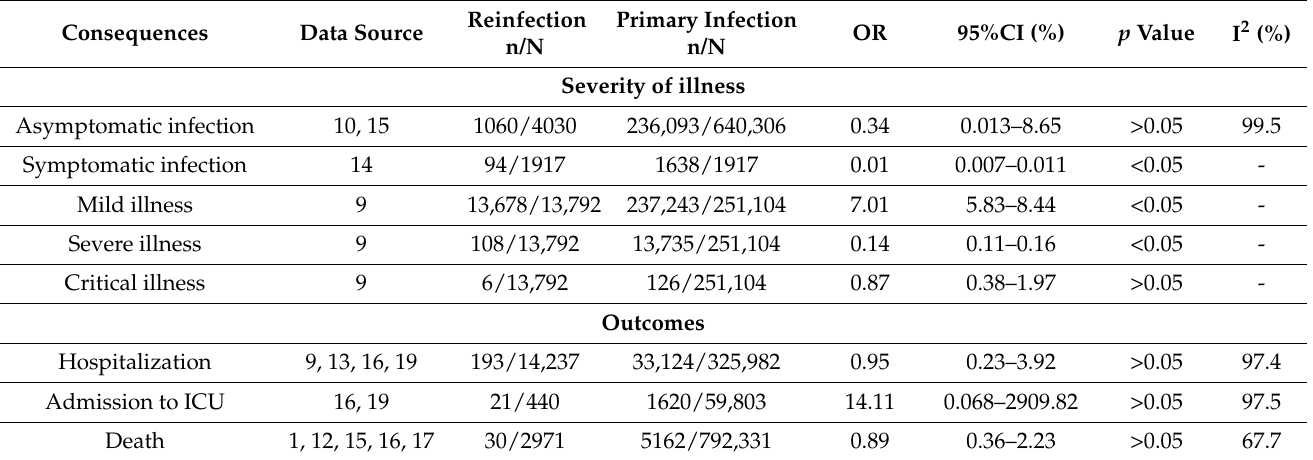
Table 3. Comparison of severity of illness and outcomes of SARS-CoV-2 reinfection and primary